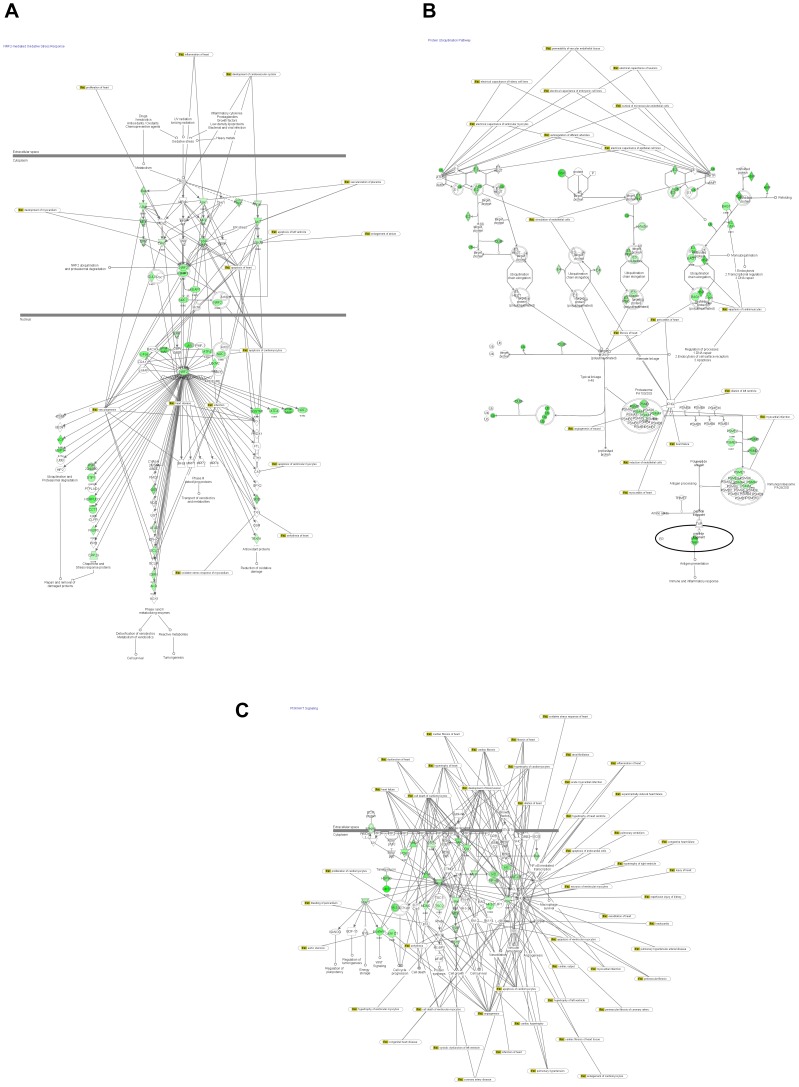
Graphical representation of NRF2-mediated oxidative stress response pathway (A), protein ubiquitination pathway (B) and PI3K/AKT canonical pathways (C), (IPA), overlaid for cardiovascular disease.Green-notes indicate down-regulated gene.